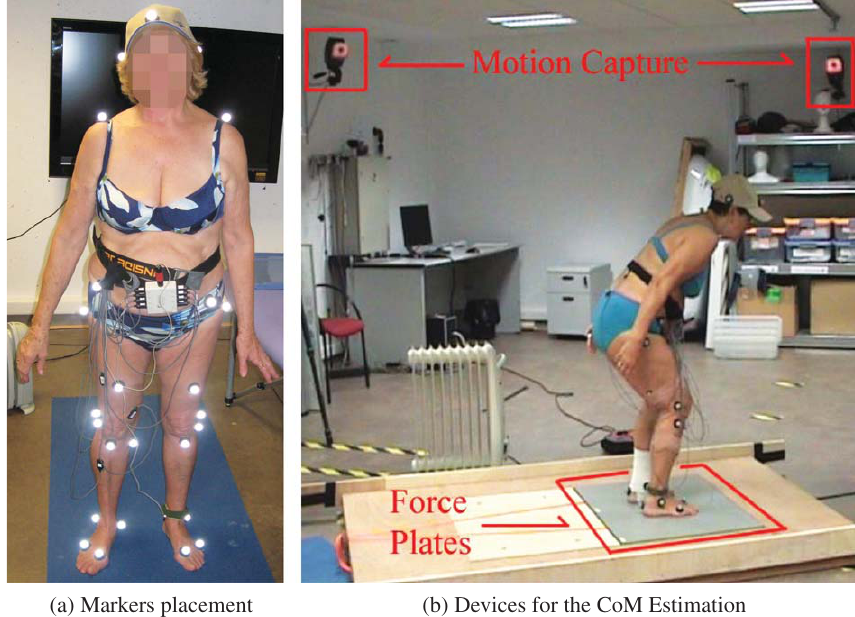
Fig. 3. Experimental environment: (a) Marker locations on the subject. (b) Motion capture and force plate devices used to estimate the CoM.